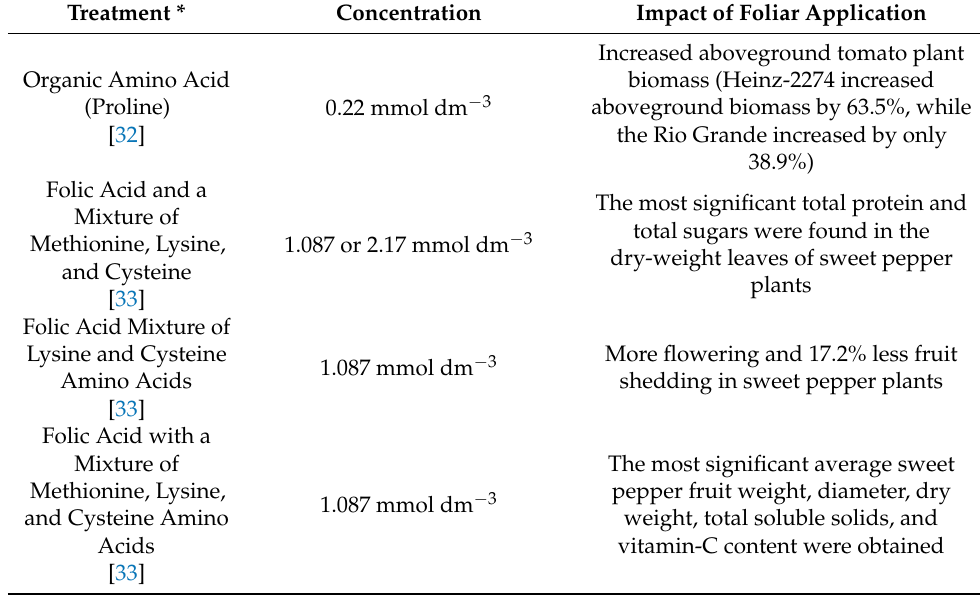
Table 5. Impact of experiments with foliar amino acid applications on tomato and pepper plants. Treatment